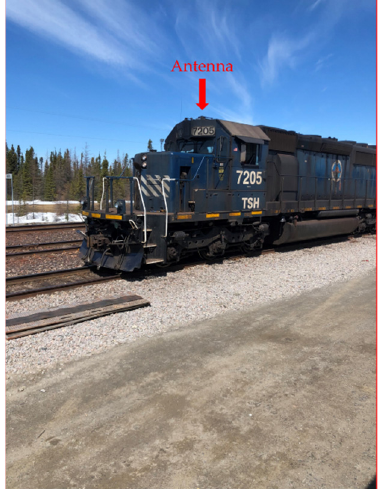
Figure 22. Antenna fixed to the top of the train.